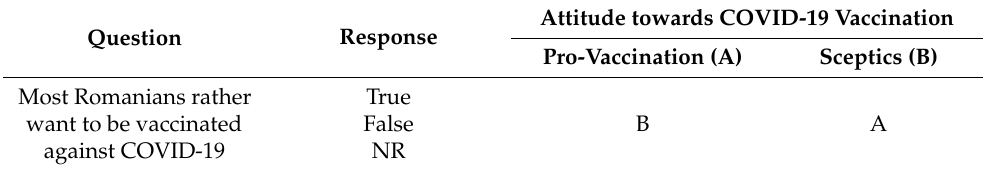
Table 8. Pro-vaccination vs. skeptical population on ‘Most Romanians rather want to be vaccinated against COVID-19 ′ .